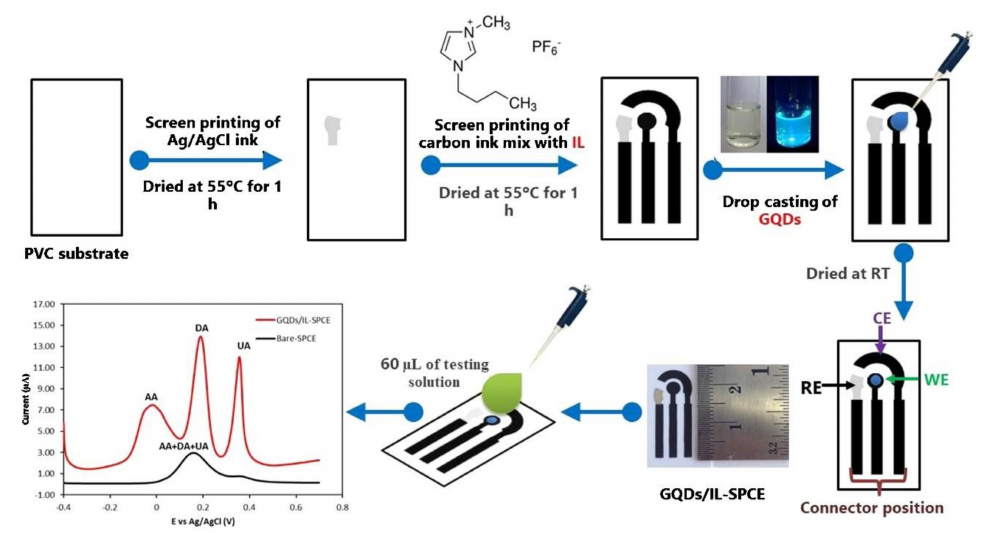
Figure 12. Schematic diagram of GQDs / IL-SPCE development and DPV detection. Reprinted from [217] with permission of Elsevier.